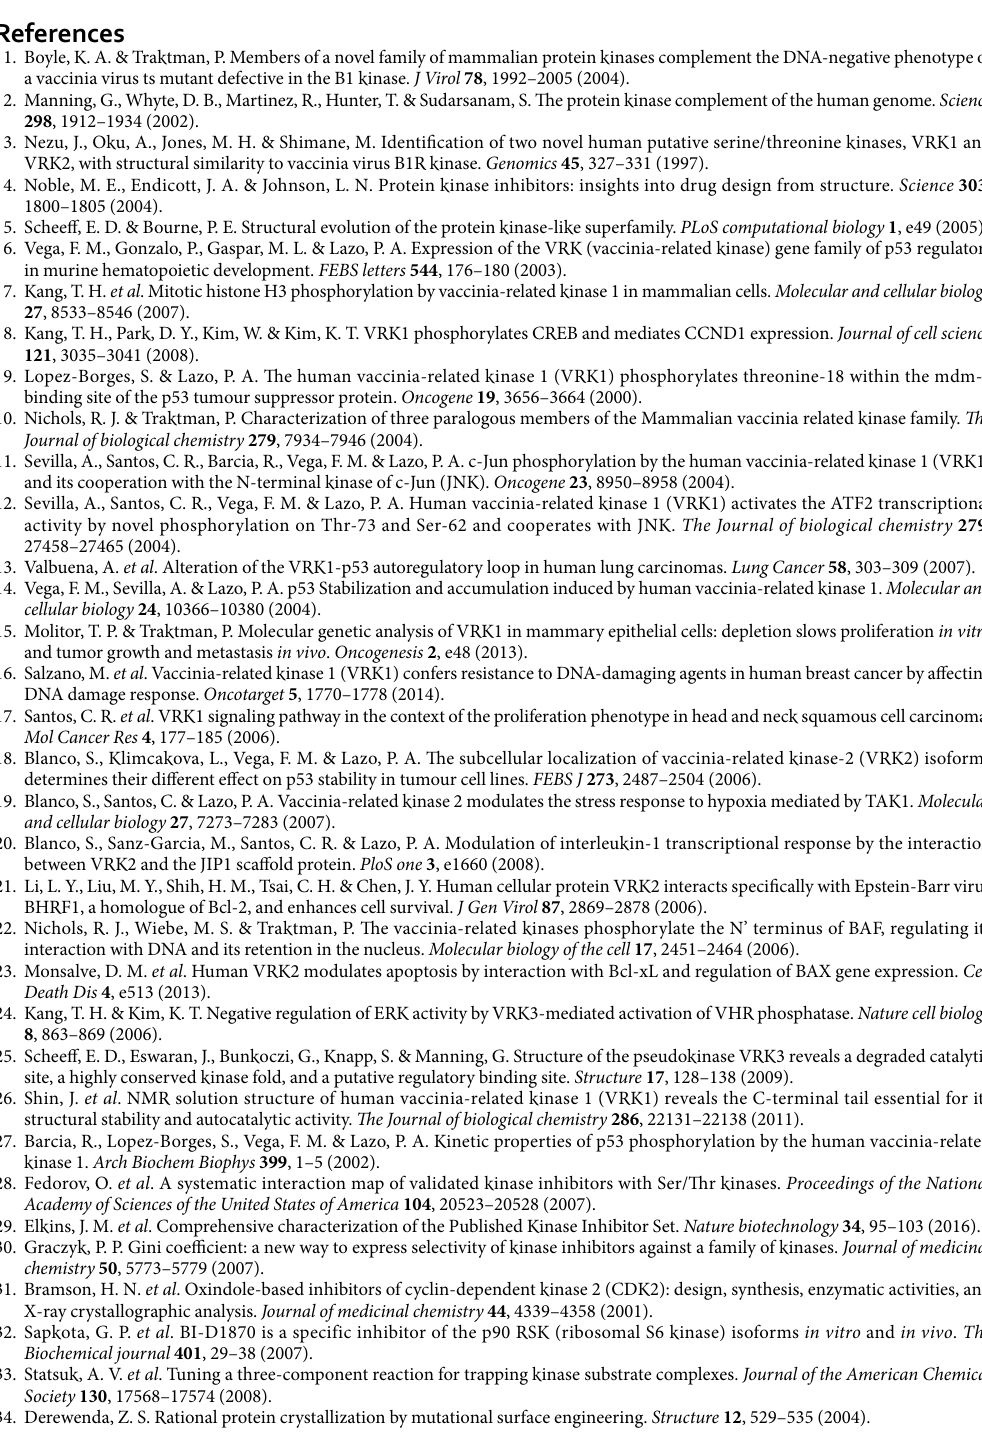
experiments were performed in a 384-well plate format. Each well contained 25 μ L of 1 μ M kinase in potas- sium phosphate buffer and the Protein Thermal Shift dye at the recommended concentration of 1:1000 (Applied Biosystems; the composition of the buffer and the dye solutions are not disclosed). Compounds (10 mM) in DMSO were added to 16 μ M final concentration to complete a total assay volume of 25.8 μ L (3.1% final DMSO). Plates were sealed using optically clear films and transferred to a QuantStudio 6 qPCR instrument (Applied Biosystems). Fluorescence intensity data were acquired in a temperature gradient from 25 to 95 °C at a constant rate of 0.05 °C/sec and protein melting temperatures were calculated based on a Boltzmann function fitting to experimental data, as implemented in the Protein Thermal Shift Software (Applied Biosystems). Protein in 3.1% DMSO was used as a